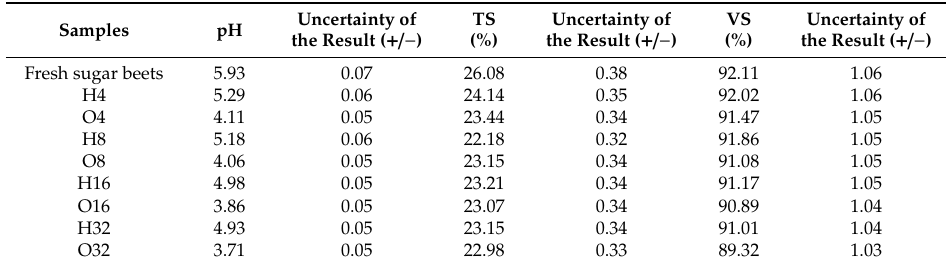
Table 1. Physicochemical studies on the analyzed samples stored in airtight conditions and in an open-air container.